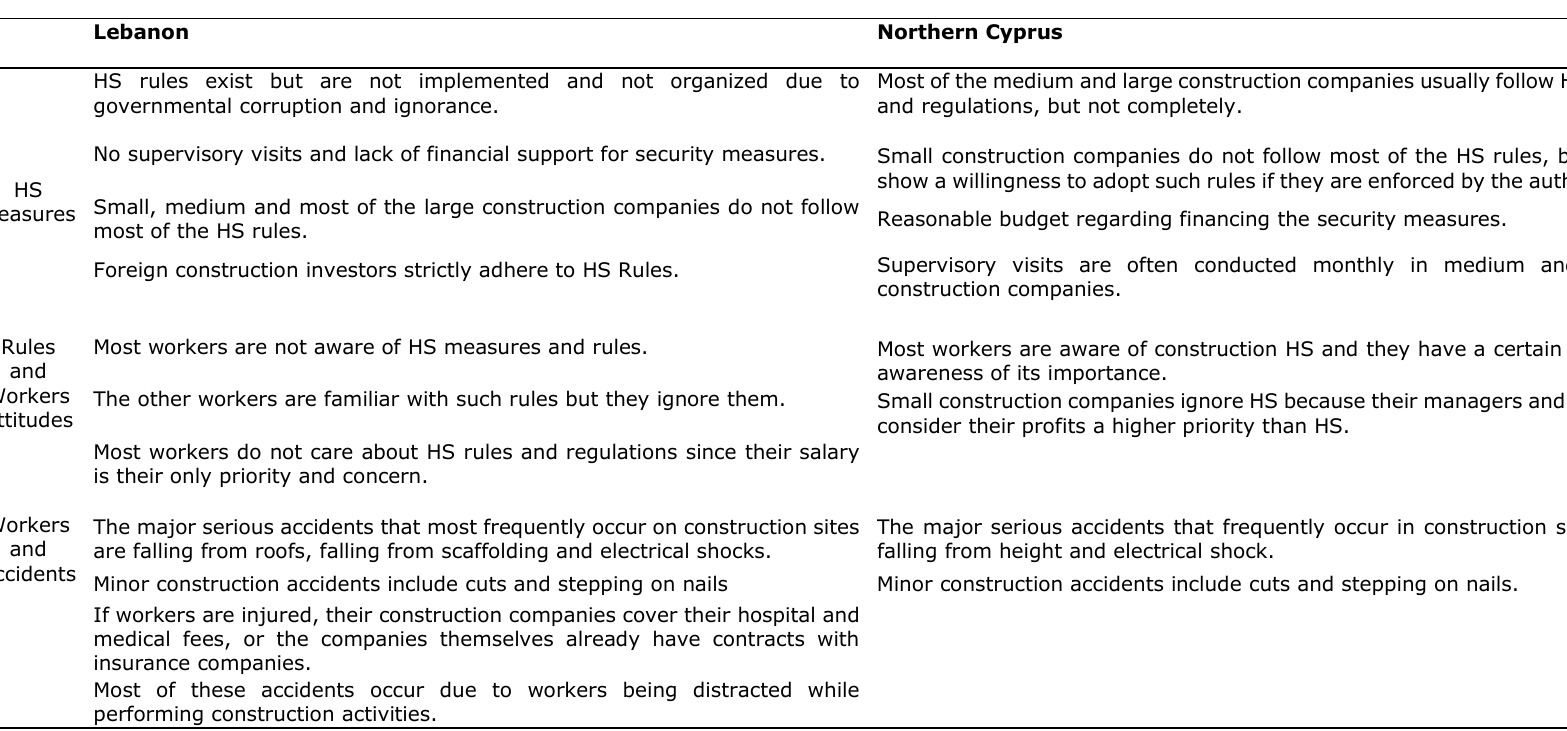
Table 3. Data Collected via Personal Observations and Informal Oral Interviews in Lebanon and Northern